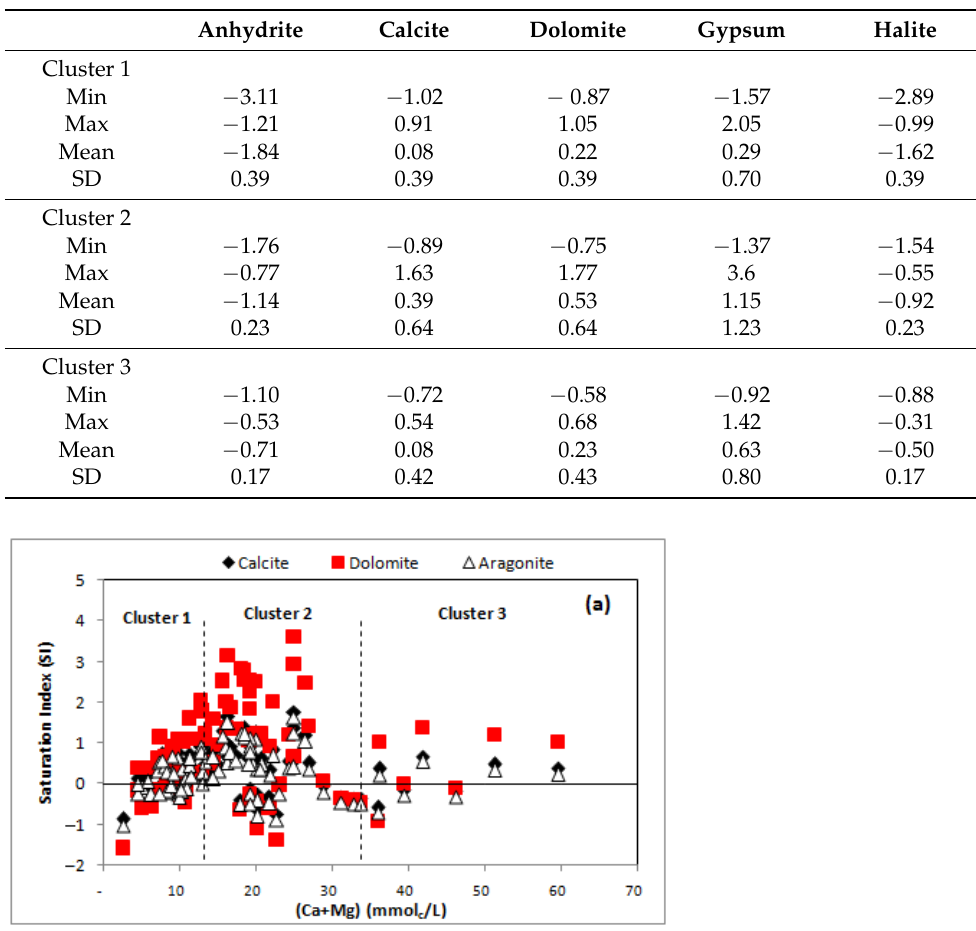
Figure 10. Saturated index of: ( a ) carbonates minerals; ( b ) Gypsum-Anyhydride; ( c ) Halite. Table 3. Summary of minerals Saturation Index ( SI ) in groundwater using PHREEQC. Anhydrite